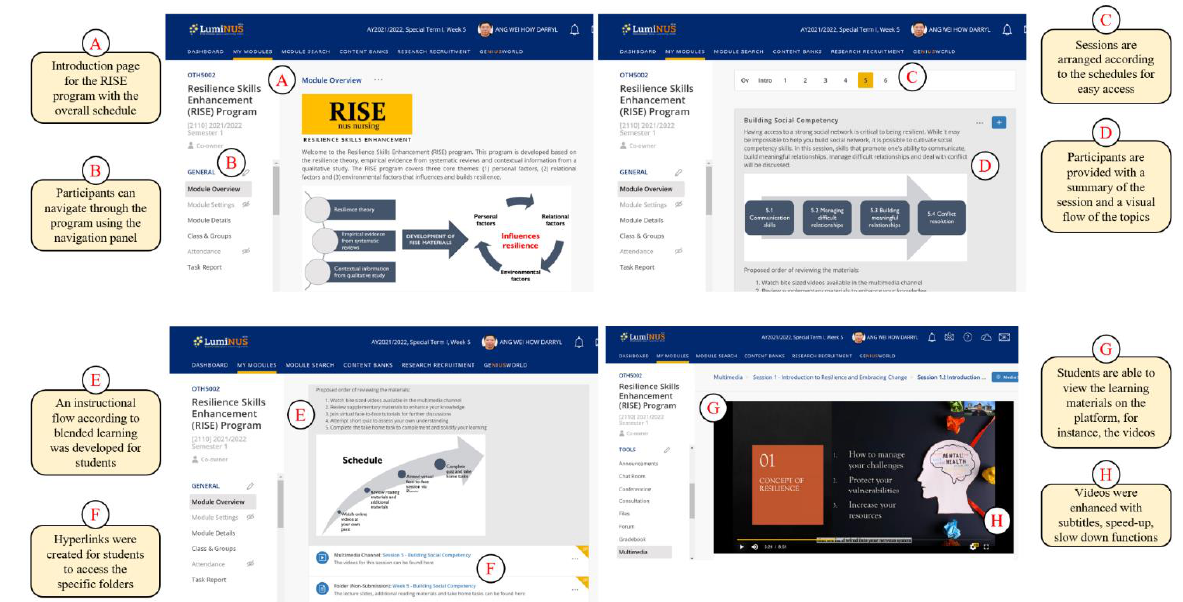
Figure 2. Web interface of the RISE program through the online learning platform. The digital RISE program adopted the blended learning framework [29]. In each week, students were provided access to review the online resources (e.g., reading materials and videos) at their own pace. Online videos comprised traditional lectures or narratives in the form of interviews with invited content experts. In light of the COVID-19 pandemic and numerous competing priorities, physical sessions were replicated in a virtual setting and were held remotely via virtual face-to-face discussions through Zoom (Weeks 1, 5, and 6) and forums (Weeks 2, 3, and 4). At the end of each week, participants were provided with take home tasks and quizzes that aimed to consolidate and evaluate their learning outcomes. Weekly reminders were sent via the learning platform’s announcement function and emails. The total possible duration (inclusive of videos and virtual discussions) for the RISE program was 365.89